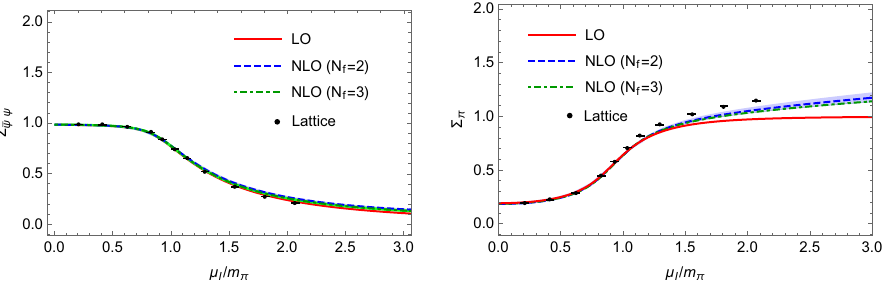
Figure 4. Σ ¯ ψψ (left panel) and Σ π (right panel) as functions of μ I / m π at zero temperature and finite source j = 0 . 00517054 m π . Fig. taken from Ref.